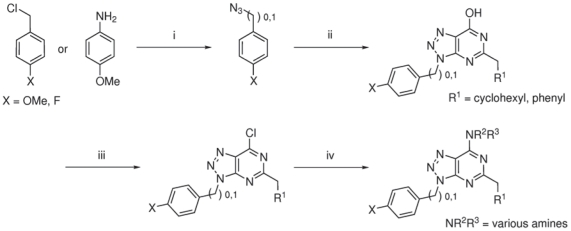
Route of synthesis of the Azapurine derivatives.(i) NaN3, acetonitrile, 100°C, 90 mins; or H2SO4, NaNO2, H2O, 5°C, 10 mins, then NaN3, hexane 5°C – RT, 2 hrs. (ii) NaOEt, ethanol, cyanoacetamide, ethyl cyclohexylacetate (or ethyl phenylacetate), 110°C, overnight. (iii) POCl3, microwave, 130°C, 10 mins. (iv) HNR2R3, Et3N, dichloromethane, microwave, 110°C, 10 mins.